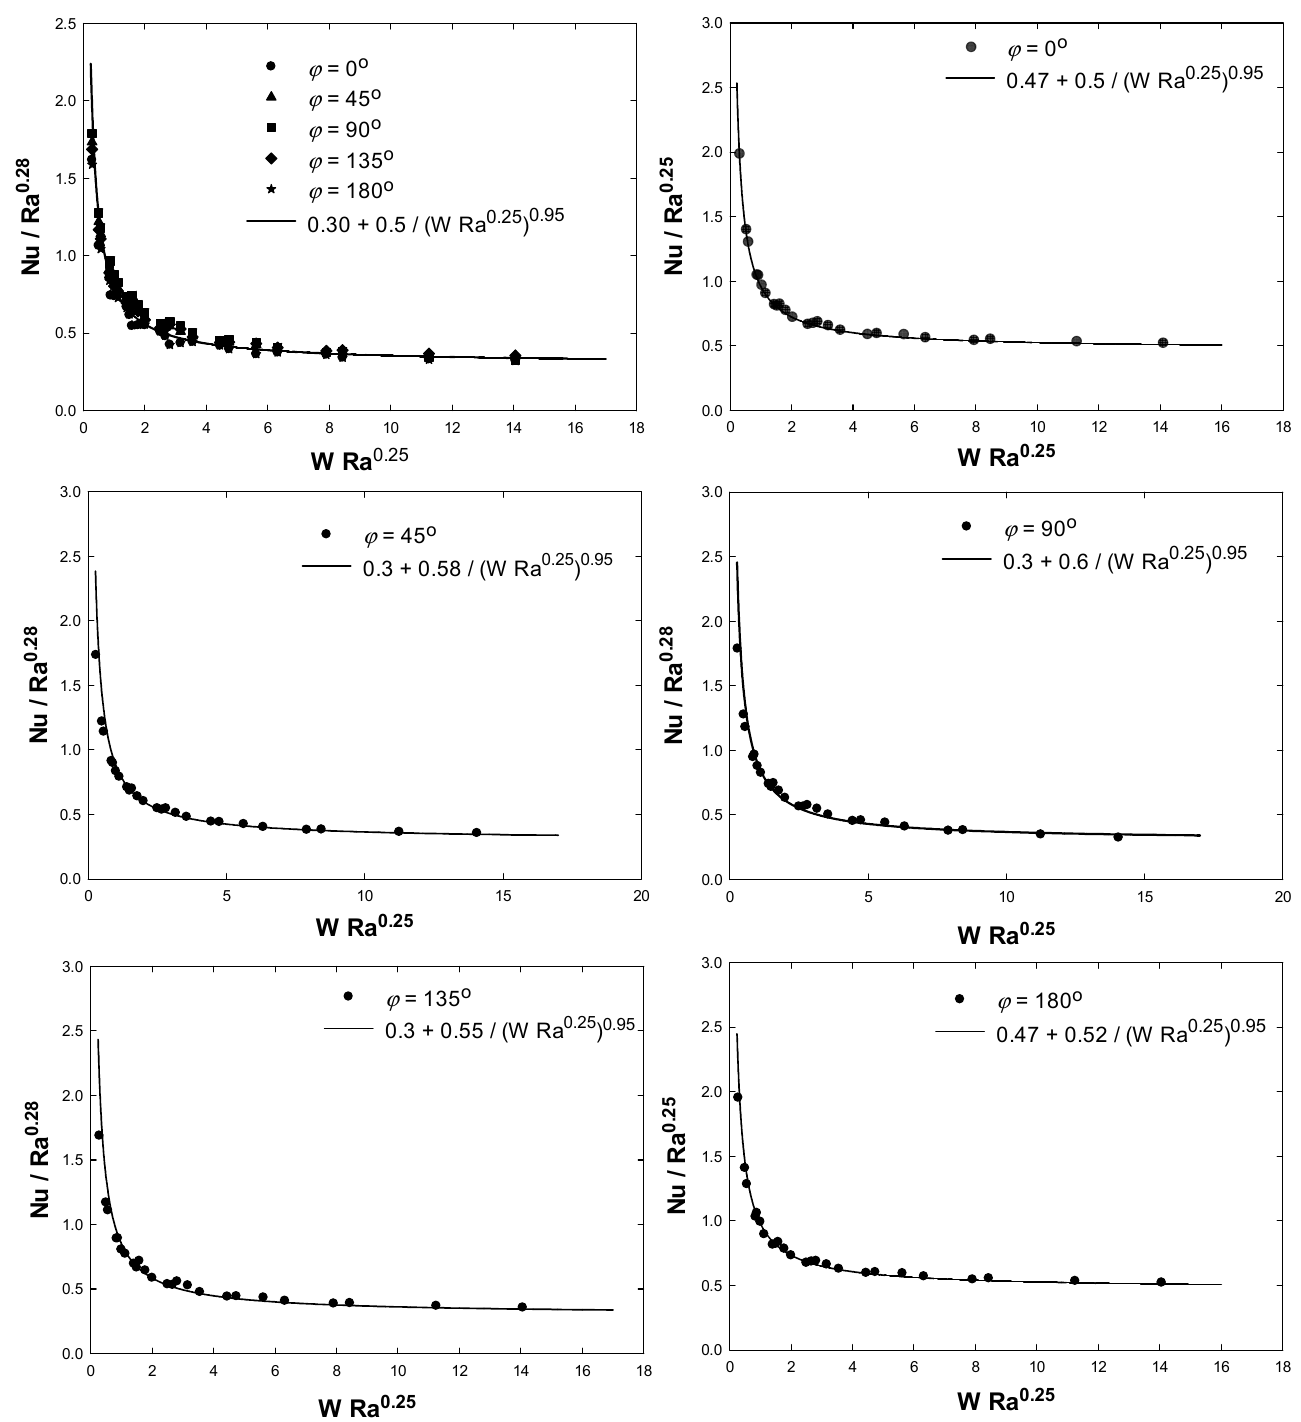
Figure 20. Comparison between present correlation equation and numerical results for different inclination angles φ = 0 ° , 45 ° , 90 ° , 135 ° , and 180 ° .